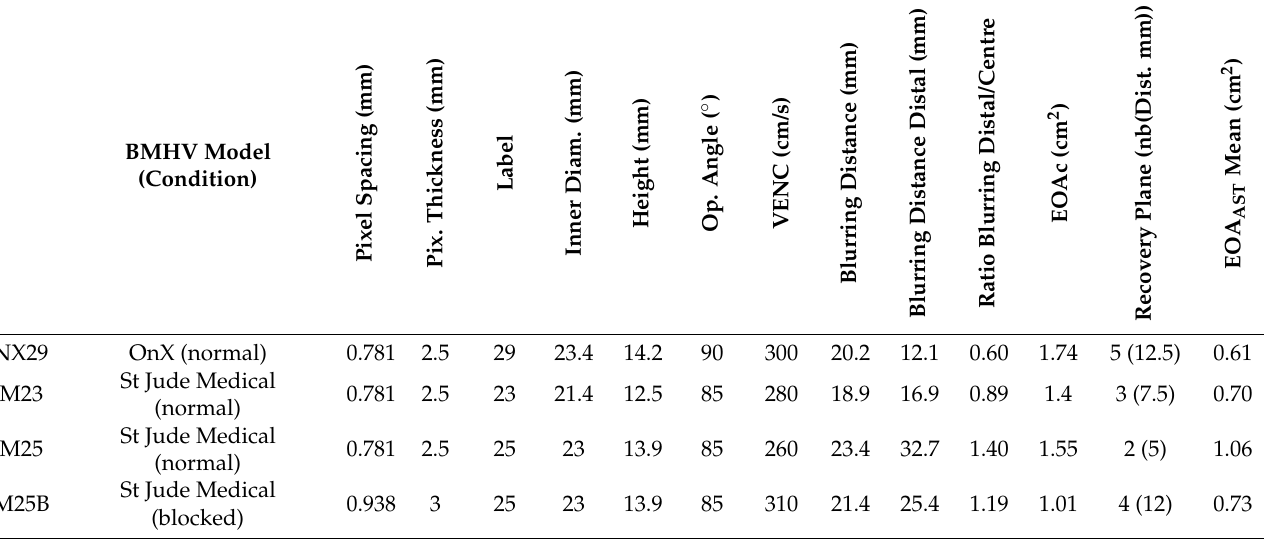
Table 1. MRI acquisition settings and results on the 4 tested BMHV models: MRI 4D Phase-Contrast flow sequences characteristics, blurring distances and EOA computation. VENC: velocity encoding.